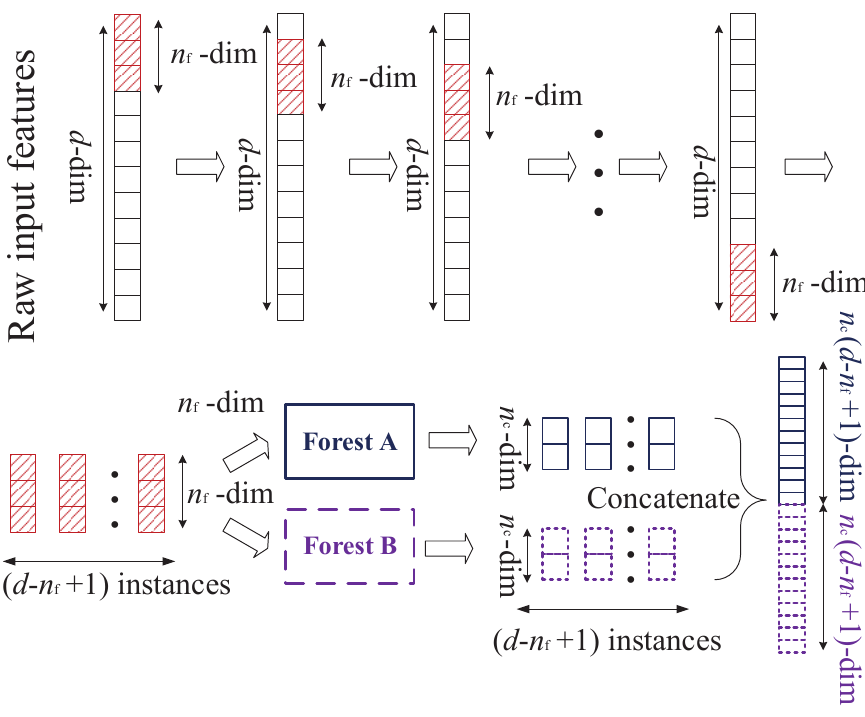
Figure 3. Multi-grained scanning